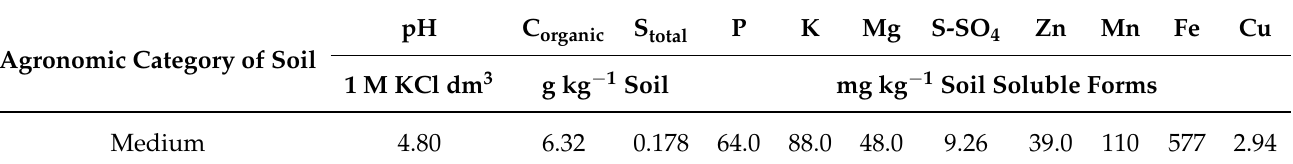
Table 1. Physico-chemical properties of the soil before the